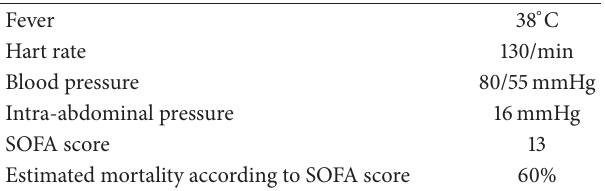
Table 1: Vital parameters and intra-abdominal pressure at admis- sion to our clinic.